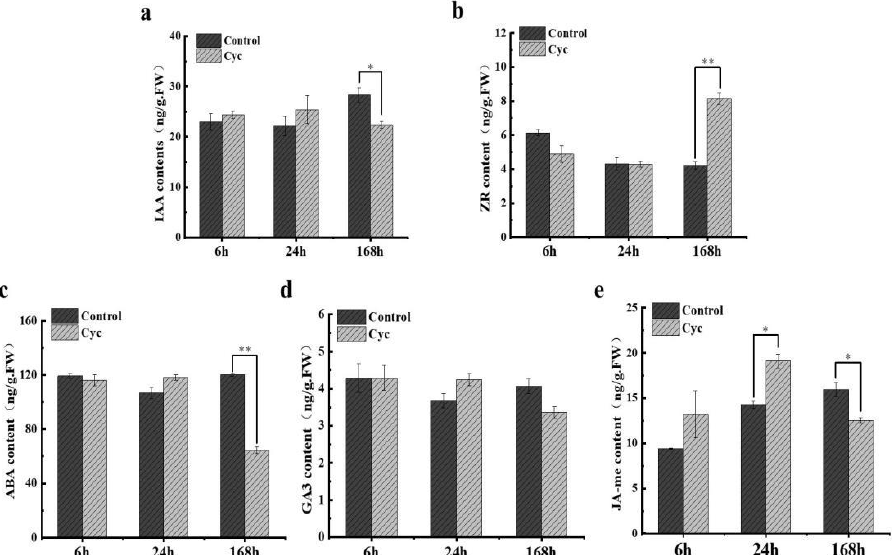
Figure 3. Hormone content in axillary buds at 6–168 h after application of cyclanilide. ( a ) IAA (indole-3-acetic acid) content ( b ) ZR (zeatin riboside) content ( c ) ABA (abscisic acid) content ( d ) GA 3 (Gibberellin 3) content ( e ) JA-me (methyl jasmonate) content. Cyc: cyclanilide. Data represent the mean ± SD ( n = 3). Asterisk indicates significant differences based on a t -test ( p < 0.05). Double asterisks indicate extremely significant differences based on the t -test ( p < 0.01).